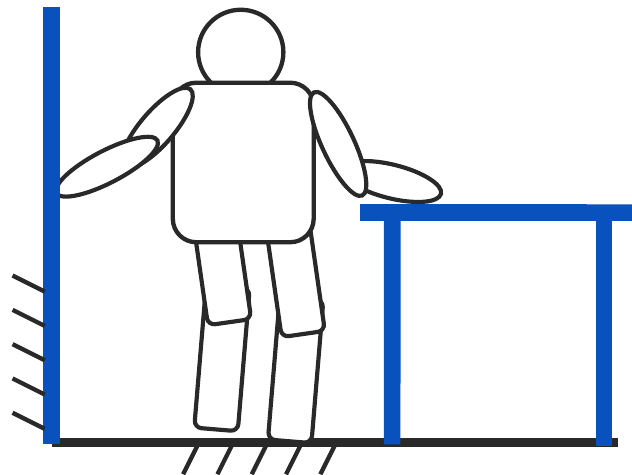
Figure 8. Use of both arms: Touching a wall and a table by each